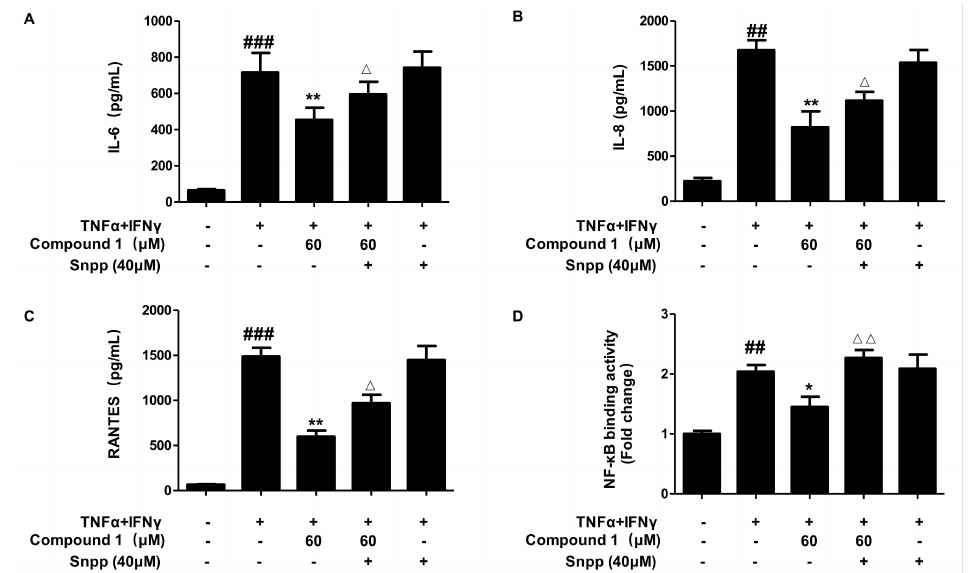
Figure 9. Anti-inflammatory effects of compound 1 through HO-1 regulation ( A – D ). HaCaT cells were pre-treated for 3 h with compound 1 (60 µ M) or not (-) in the presence (+) or absence (-) of SnPP (40 µ M) and stimulated with TNF- α /IFN- γ (+) for 24 h to measure IL-6 ( A ), IL-8 ( B ), and RANTES ( C ) or for 15 min to measure NF- κ B binding activity ( D ). The levels of IL-6, IL-8, and RANTES, and NF- κ B binding activity were detected by ELISA. Data are represented as the mean ± SD of three independent experiments., ## p < 0.01, ### p < 0.001 vs. control. * p < 0.05, ** p < 0.01, vs. TNF- α /IFN- γ -treated group. (cid:52) p < 0.05, (cid:52)(cid:52) p < 0.01, vs. compound 1 +TNF- α /IFN- γ - treated